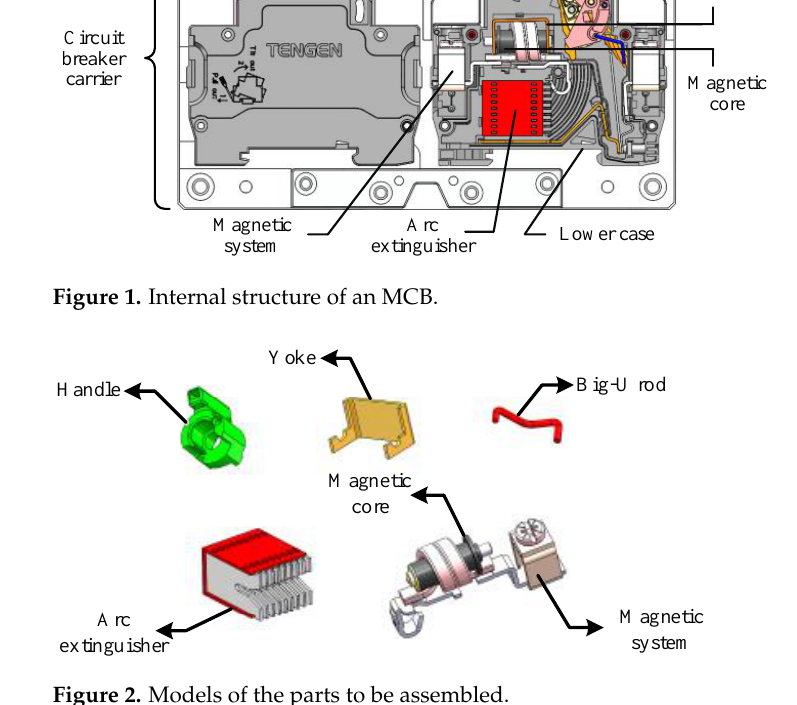
Figure 2. Models of the parts to be assembled.